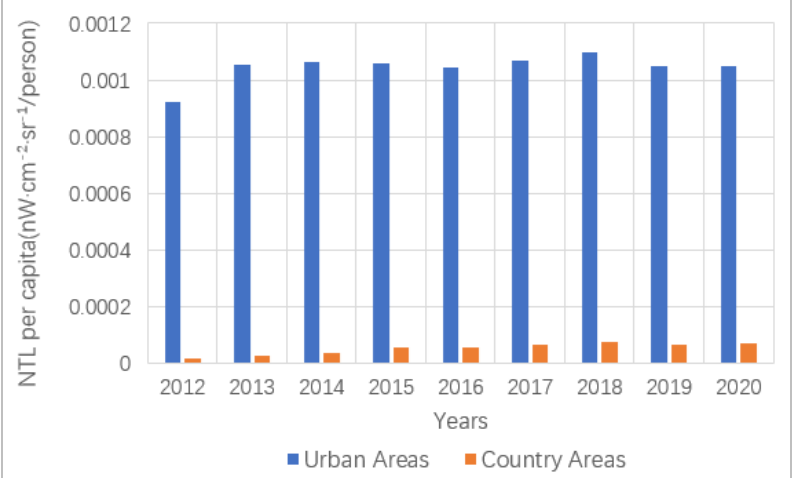
Figure 10. NTL per capita of the urban and rural areas in Rwanda from 2012 to 2020.